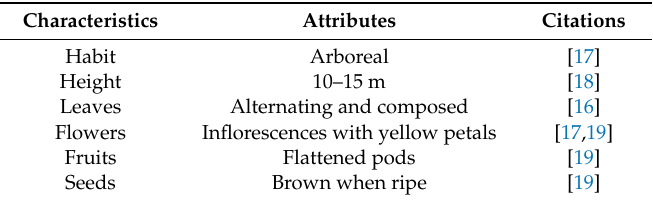
Table 1. Summary of the C. ferrea botanical